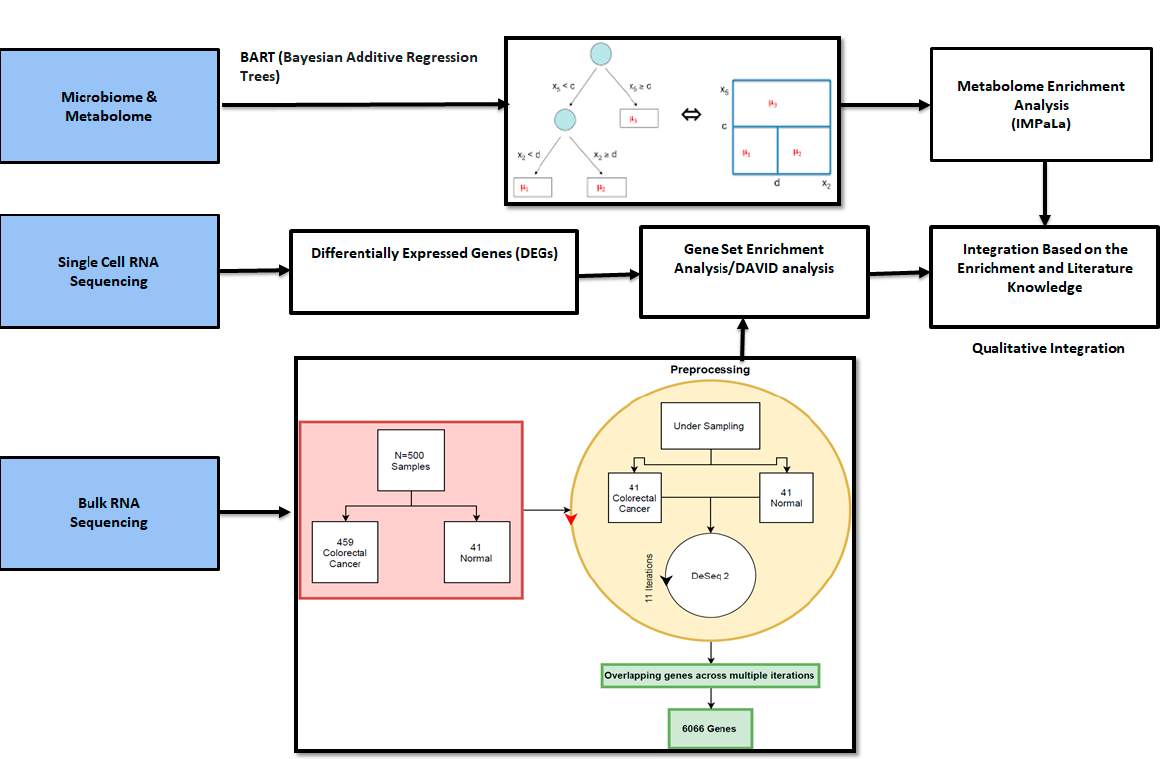
Figure 7. Diagrammatic representation of the qualitative integration of different methods and omics data sets to identify markers for colorectal cancer using metabolomics, transcriptomics (single-cell RNA and bulk RNA) and microbiome data sets. Gene set enrichment was used to identify associations between the genes and metabolites.